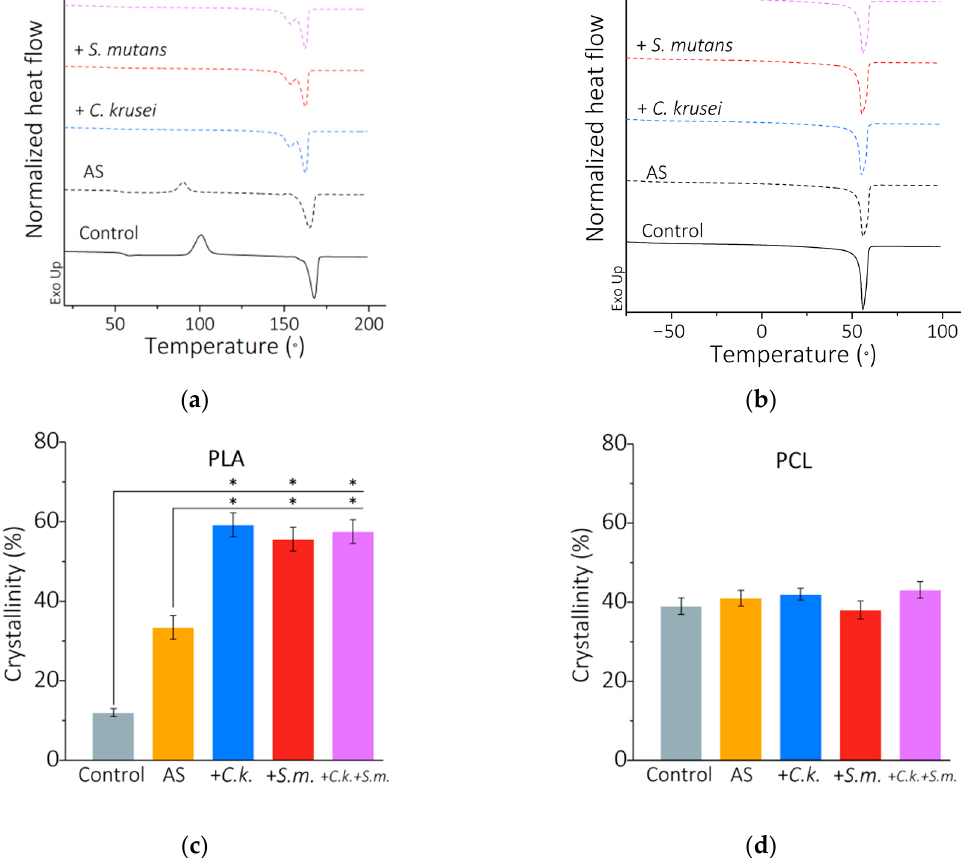
Figure 5. DSC of PLA and PCL after 56 days of incubation: ( a ) DSC curves (second heating) for PLA; ( b ) DSC (second heat) curves for PCL; ( c ) crystallinity for PLA; ( d ) crystallinity Xc for PCL. Results mean ± SD ( n = 5). (*) p < 0.05.